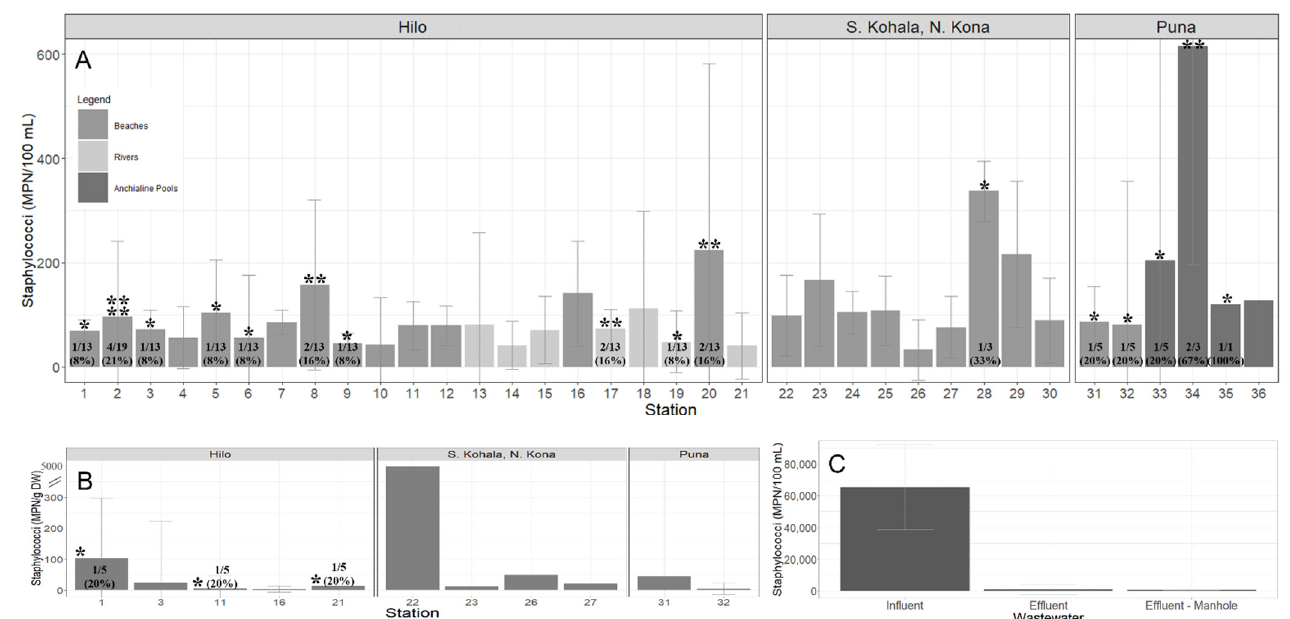
Figure 1. Geometric mean (±SE) of staphylococci collected from the districts of Hilo (stations #1–21), S. Kohala, N. Kona (stations #22–30), and Puna (stations #31–36) from July–December 2020 on Hawai ʻ i Island, Hawai ʻ i. ( A ) Staphylococcus spp. MPN/100 mL counts from water (beach/river/stream/anchialine pool) stations; ( B ) Staphylococcus spp. MPN/g DW counts from beach sand stations; ( C ) Staphylococcus spp. MPN/100 mL counts from wastewater collected from the Hilo Wastewater Treatment Plant. Detection of S. aureus is represented by the *. The number of * is how many different isolates were identified from the same station [ranging from one to four]. The prevalence of S. aureus , reported as number of detections in the total sample pool and percent, is shown at the base of each station, if detected.